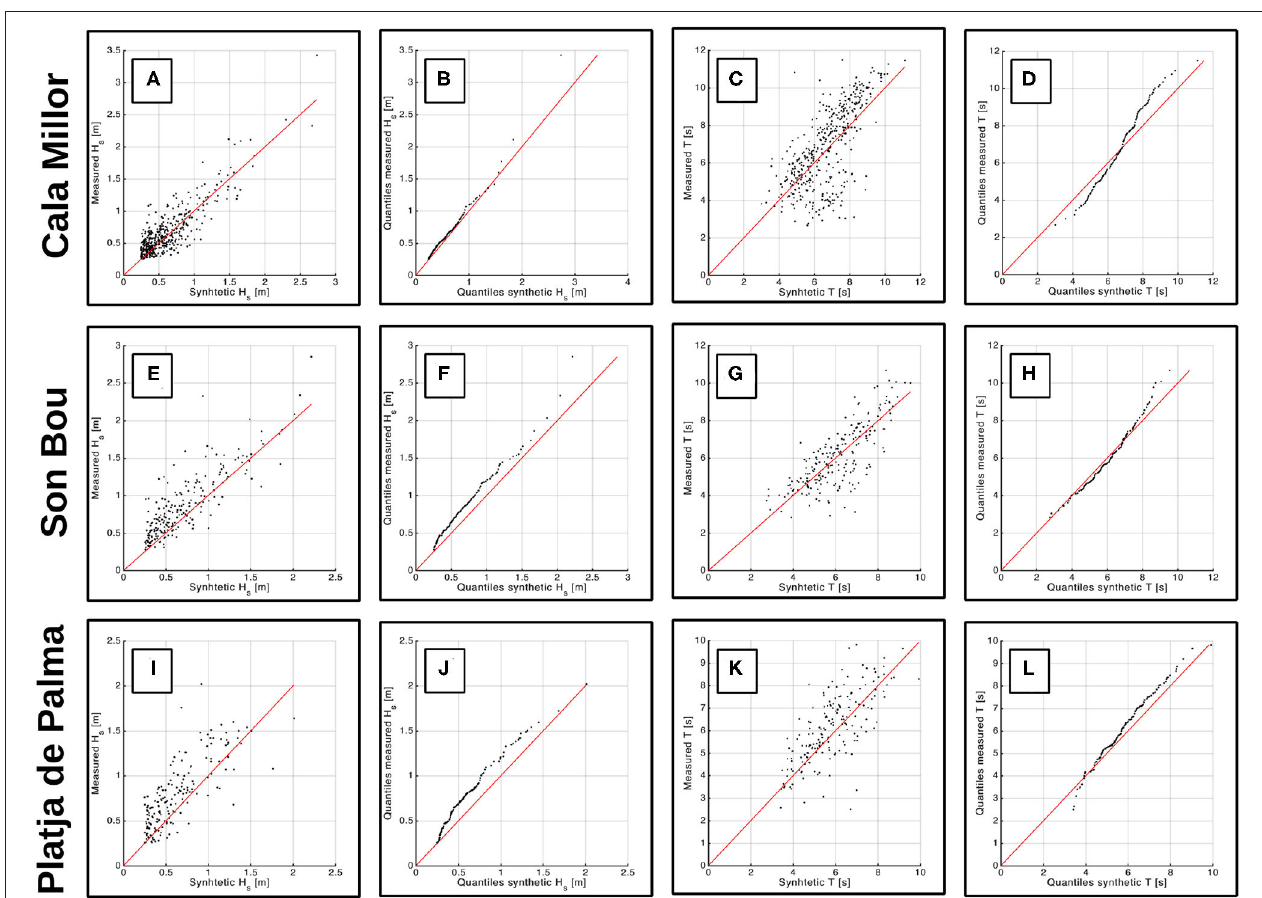
FIGURE A1 | Comparison of in situ and synthetic time series (unitary slope lines indicated in red). (A,E,I) Show H s scatter plots. (B,F,J) Show H s QQ-plots. (C,G,K) Show T scatter plots. (D,H,L) Show T QQ-plots. (A–D) Correspond to Cala Millor data; (E–H) to Son Bou data; (I–L) to Platja de Palma